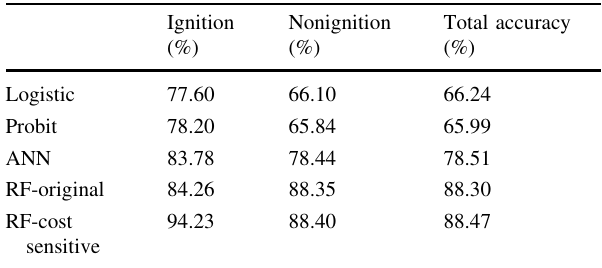
b Fig. 5 Fitting performance of the five models. Number and class percentage of true positives (TP), true negatives (TN), false positives (FP), and false negatives (FN) values for the evaluation of the fitting performance of the five models in the fourfold figures: a logistic regression, b probit regression, c ANN, d RF-original, e RF-cost sensitive Table 2 Class prediction accuracy of each model